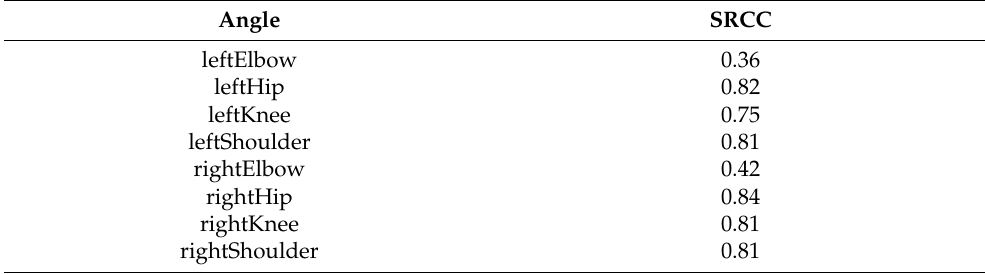
Table 3. The aggregated SRCC values for all joint